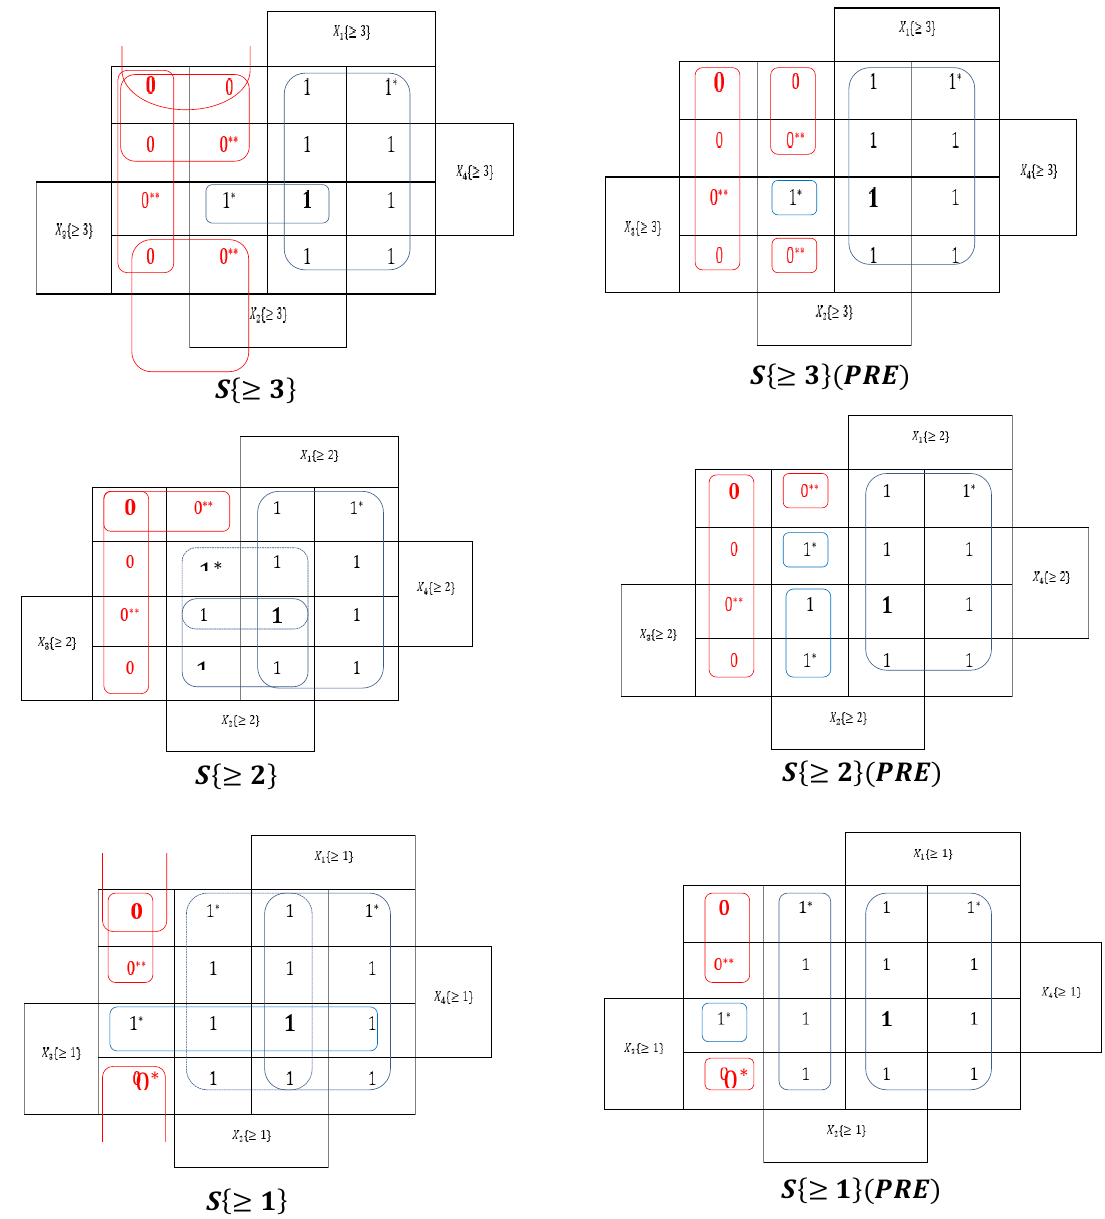
Figure 3. Prime-implicant (PI) loops for the top six expressions in Table 1, and Disjoint-implicant (DI) loops for the bottom six expressions in Table 1. A starred cell is an enlargement of a minimal upper vector, while a double-starred cell is an enlargement of a maximal lower vector. Each success (1-entered) PI loops passes through the all-1 cell, and each failure (0-entered) PI loop passes through the all-0 cell. The number of DI loops exactly equals that of the corresponding PI loops, asserting to the shellability of the pertinent